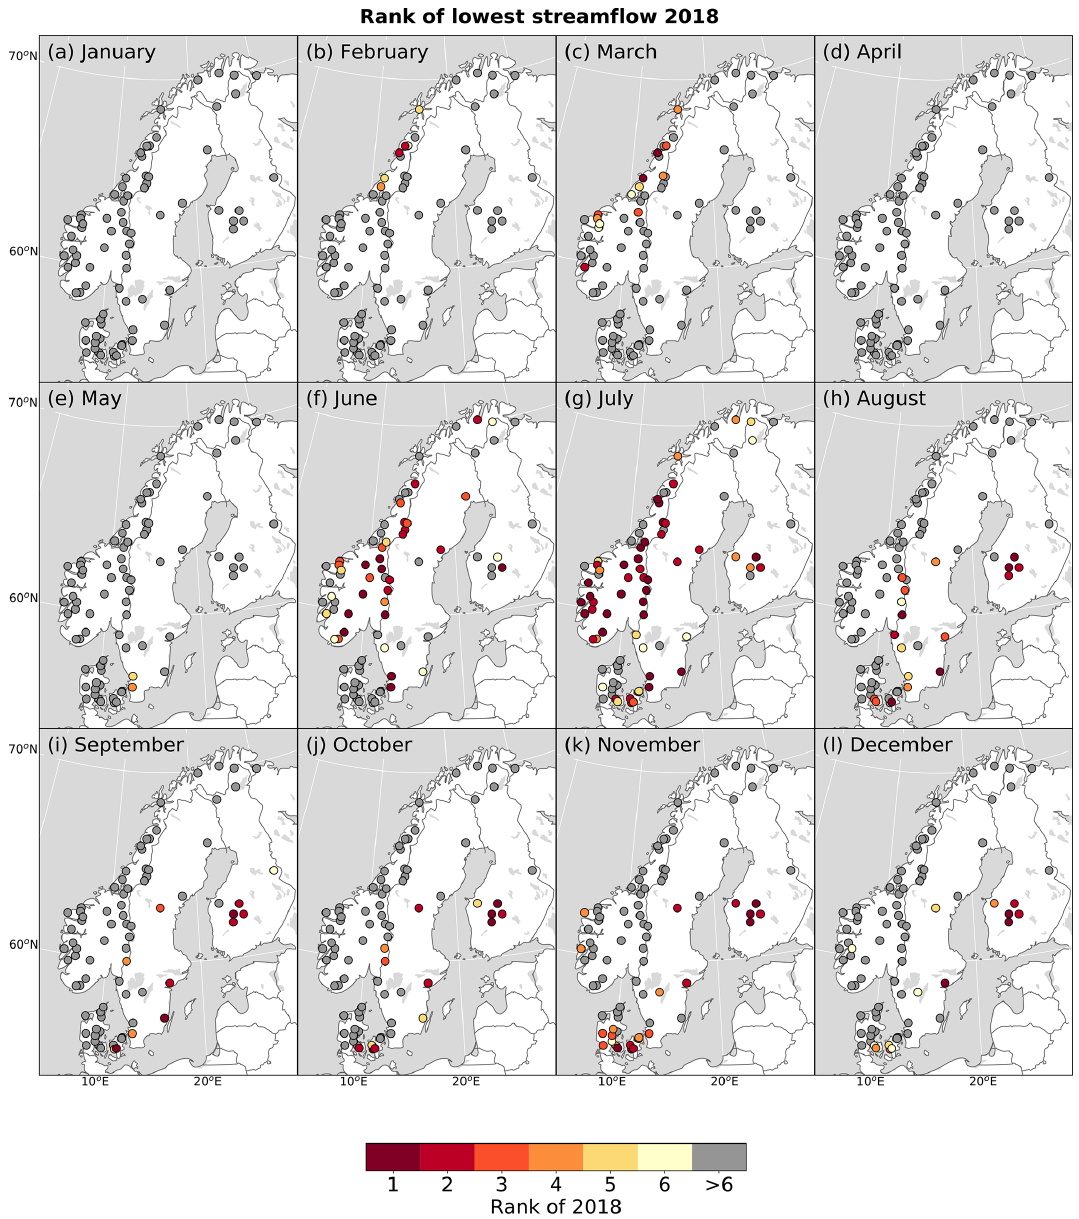
Figure A8. Top-six ranking of 2018 monthly lowest streamflow relative to the 60-year period (1959–2018).